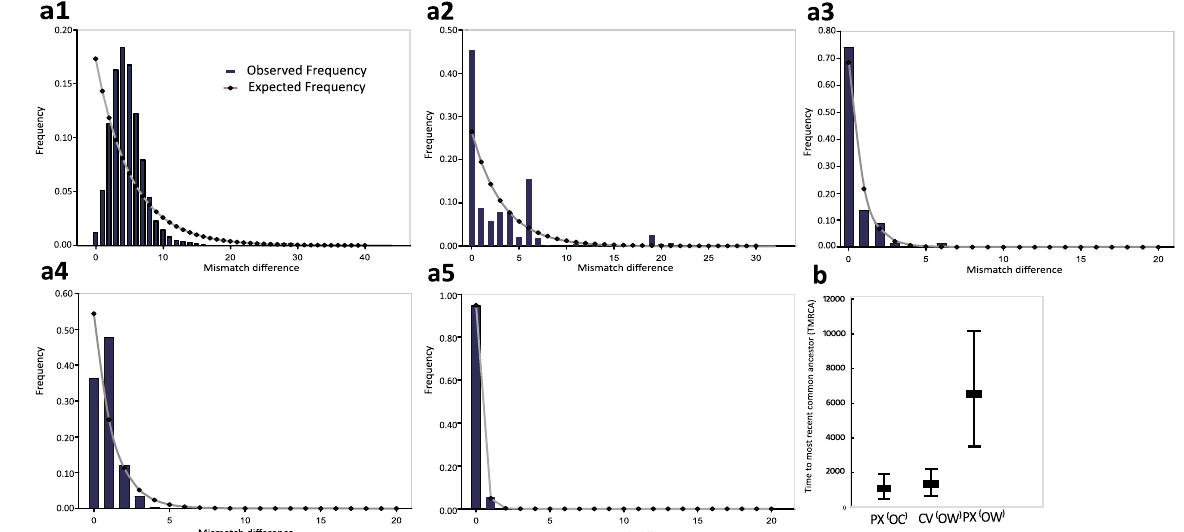
Figure 4. Demographic Inference. ( a1 – a5 ) Mismatch distributions of P. xylostella and C. vestalis based on three concatenated genes, CoxI , Cytb and NadhI ( a1 ) P. xylostella with all sampled individuals; ( a2 ) C. vestalis with all sampled individuals; ( a3 ) Lineage 1 of C . v estalis ; ( a4 ) Lineage 2 of C . v estalis ; and ( a5 ) Lineage 3 of C . v estalis ). ( b ) Estimation of the CoxI- based TMRCA for P. xylostella and C. vestalis . PX: P. xylostella ; CV: C. vestalis ; OC: Oceania; OW: Old World.